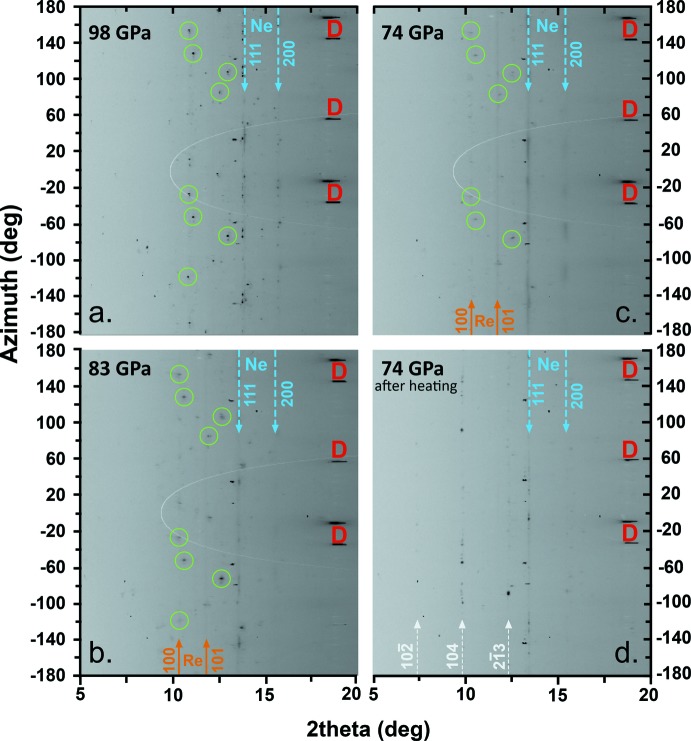
Unrolled X-ray diffraction images collected at room temperature (λ = 0.411 Å). (a) Sharp and intense reflections of (Mg2.53Fe0.47)C3O9 appear after laser-heating of the starting material at 98 GPa and 2500 K. (b) The crystal phase gradually deteriorates during decompression and (c) nearly disappears at ∼74 GPa. (d) Consequent laser-heating treatment results in the formation of the initial carbonate structure. Green circles mark a few of the characteristic reflections of (Mg2.53Fe0.47)C3O9, the position of Ne reflections and in some cases Re reflections are marked with blue and orange arrows, respectively. The 2θ positions of three characteristic carbonate (R

c) reflections are indicated with white arrows. Diamond reflections are marked in red.